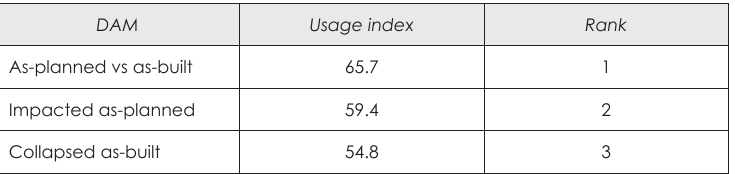
Table 5: Extent of use of